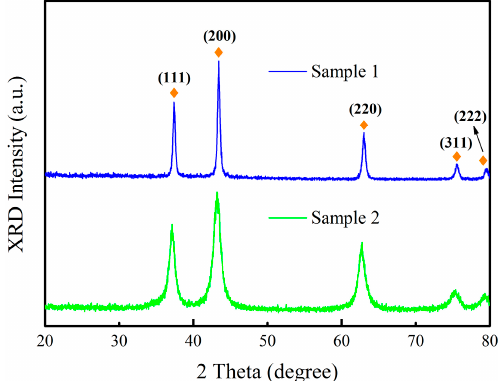
Figure 1. XRD pattern of the